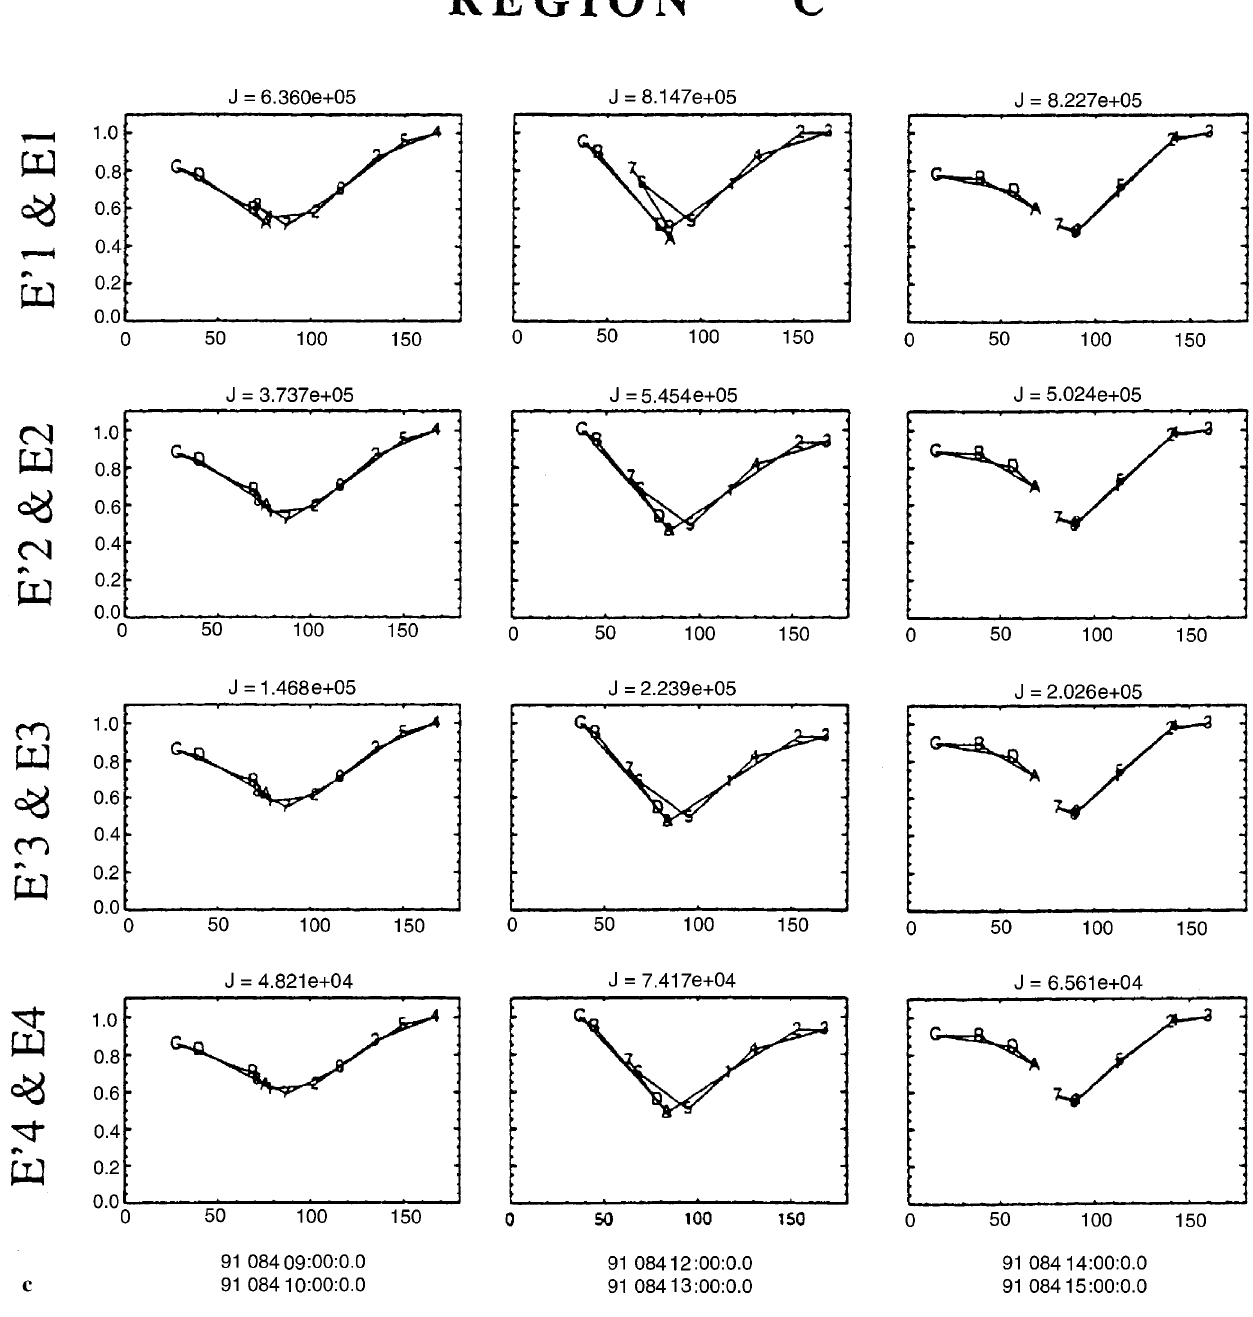
Fig. 2c. Strong field-aligned bi-directional electron fluxes are observed in region C , which is indicative of a trapped population in the downstream region of the